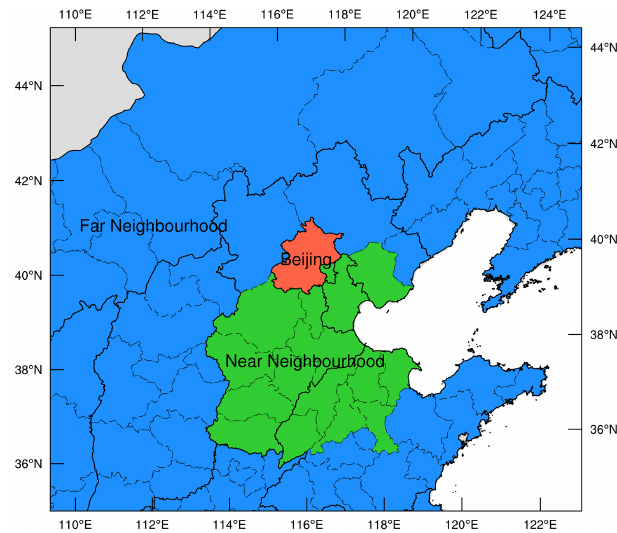
Figure 2. North China (model domain 2) showing the emission con- trol regions used in this